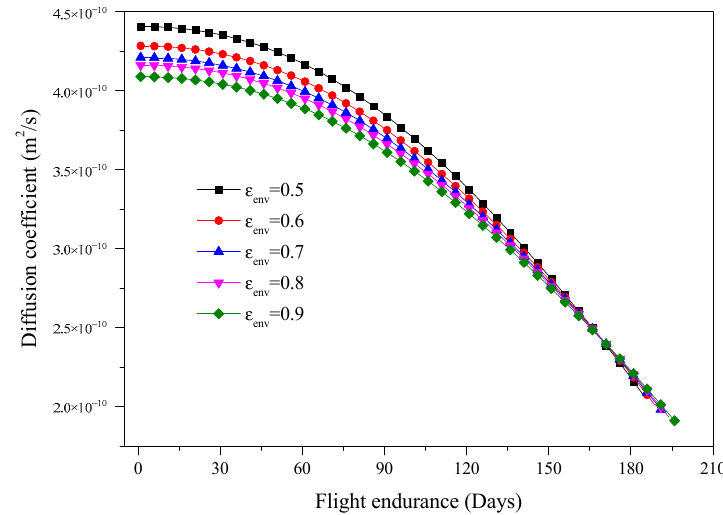
Figure 17. Effects of envelope emissivity on flight altitude.